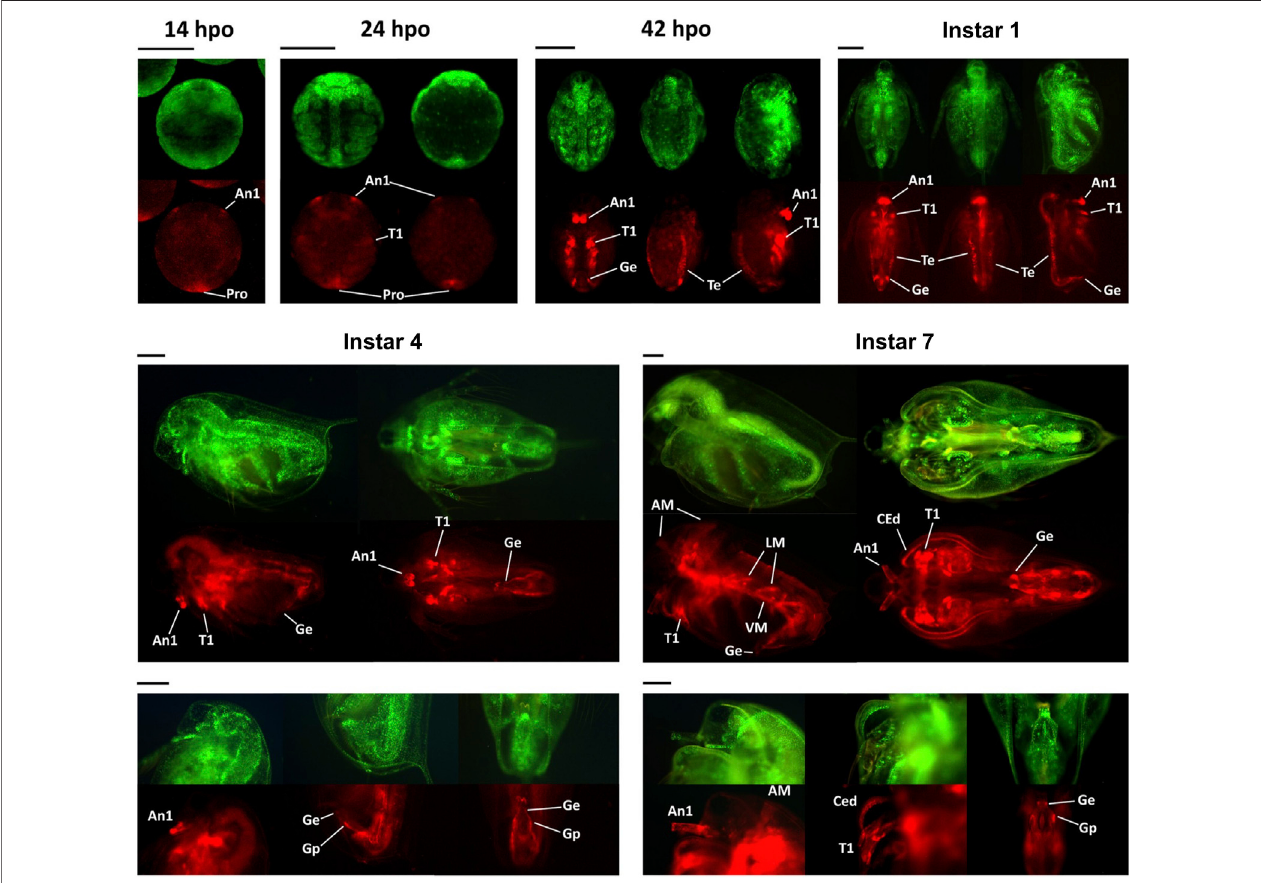
FIGURE7| Spatiallyand temporally speci fi c expressions of mCherry in the Dsx1 reporter strain.All embryos and daphniidsshown in this fi gurearemales of the Line B. hpo, hours post-ovulation; dpo, days post-ovulation. For the 14 hpo panel: ventral view. For the 24 hpo panel: ventral view (left) and dorsal view (right). For the 42 hpo and instar 1 panels: ventral view (left), dorsal view (middle), and side view with the ventral side facing right (right). A1, fi rst antenna; T1, fi rst thoracic leg; Pro, proctodeum; Ge, genital (i.e., penis in this case); Te, testis; AM, antennal muscle; LM, lateral muscle; VM, ventral muscle; CEd, carapace edge; Gp, gonopore. Scale bars = 200 μ m. Adapted from Nong et al. (2017).